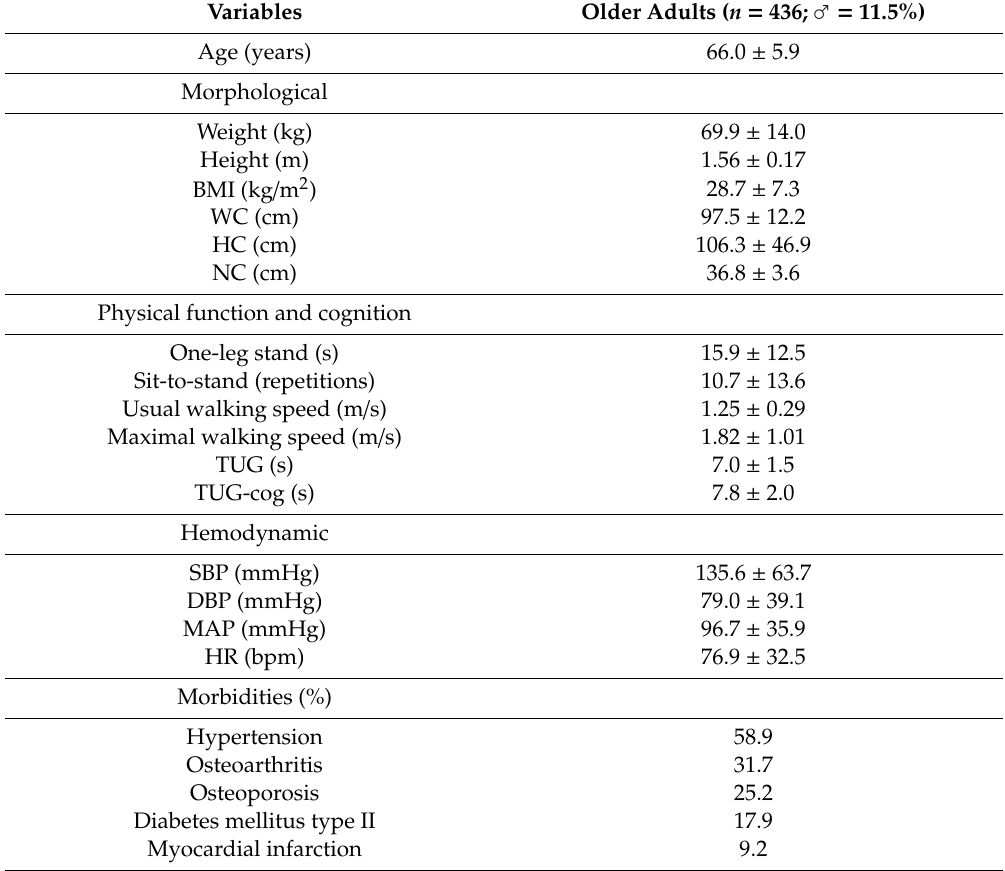
Table 1. Overall characteristics of the studies sample.